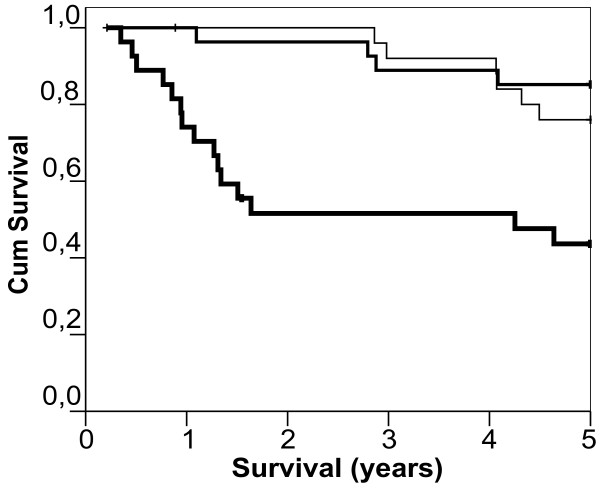
Kaplan Meyer plot of 81 patients divided into tertiles based on suPAR levels. Patients with low suPAR (N = 27, thin line), median suPAR (N = 27, median thick line) and high suPAR (N = 27, thick line).